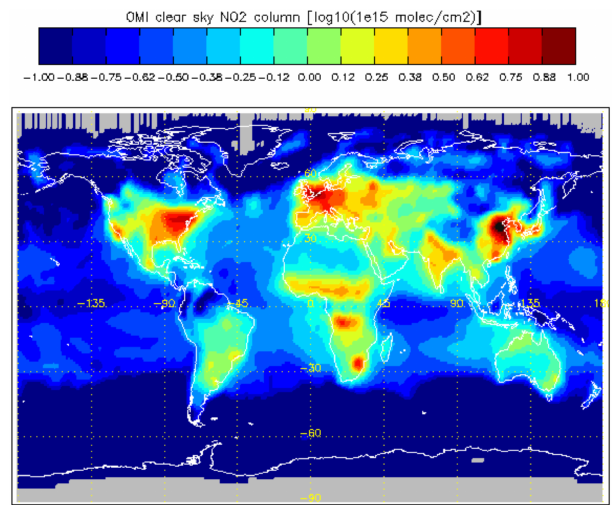
Figure 12. Annual clear-sky OMI tropospheric NO 2 total columns in logarithmic scale for the year